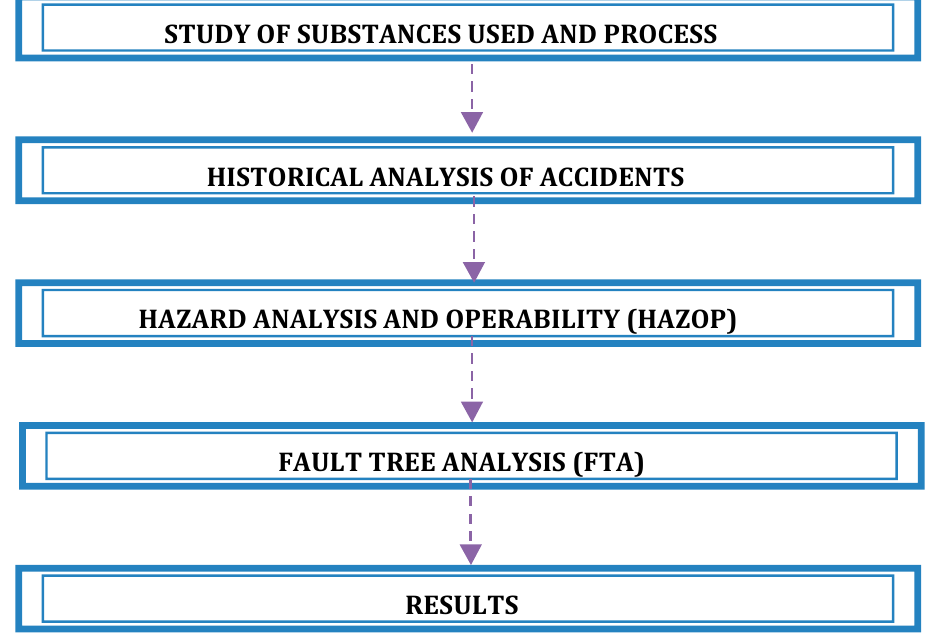
Figure 1. Methodology of study.